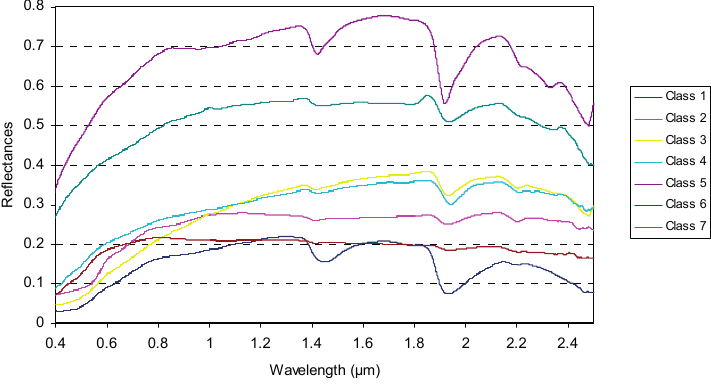
Figure 2. A priori soil classes according to the spectral behaviour of the dry soil samples. According to [20], the soil samples with the same spectral behaviour are then grouped together in seven a priori spectral classes defined by Figure 2 and Table